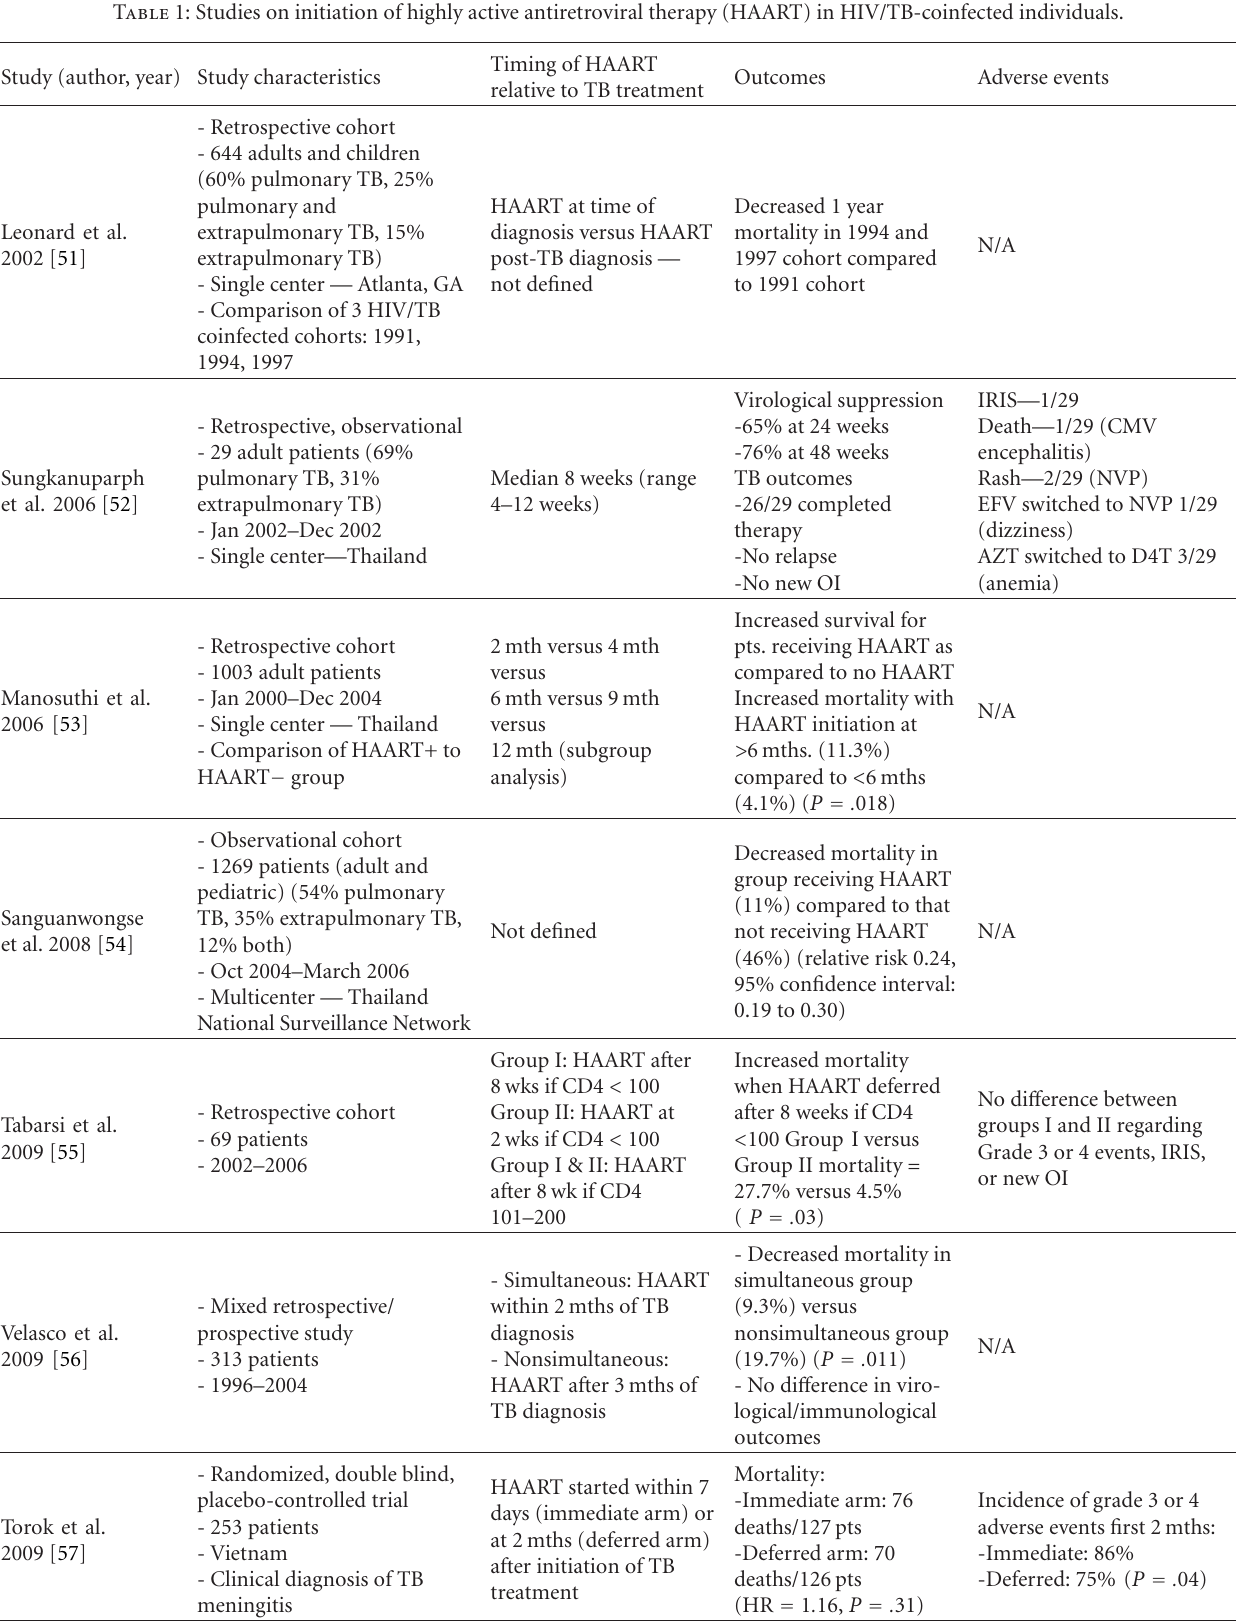
Table 1: Studies on initiation of highly active antiretroviral therapy (HAART) in HIV/TB-coinfected individuals. Timing of HAART Study (author, year) Study characteristics